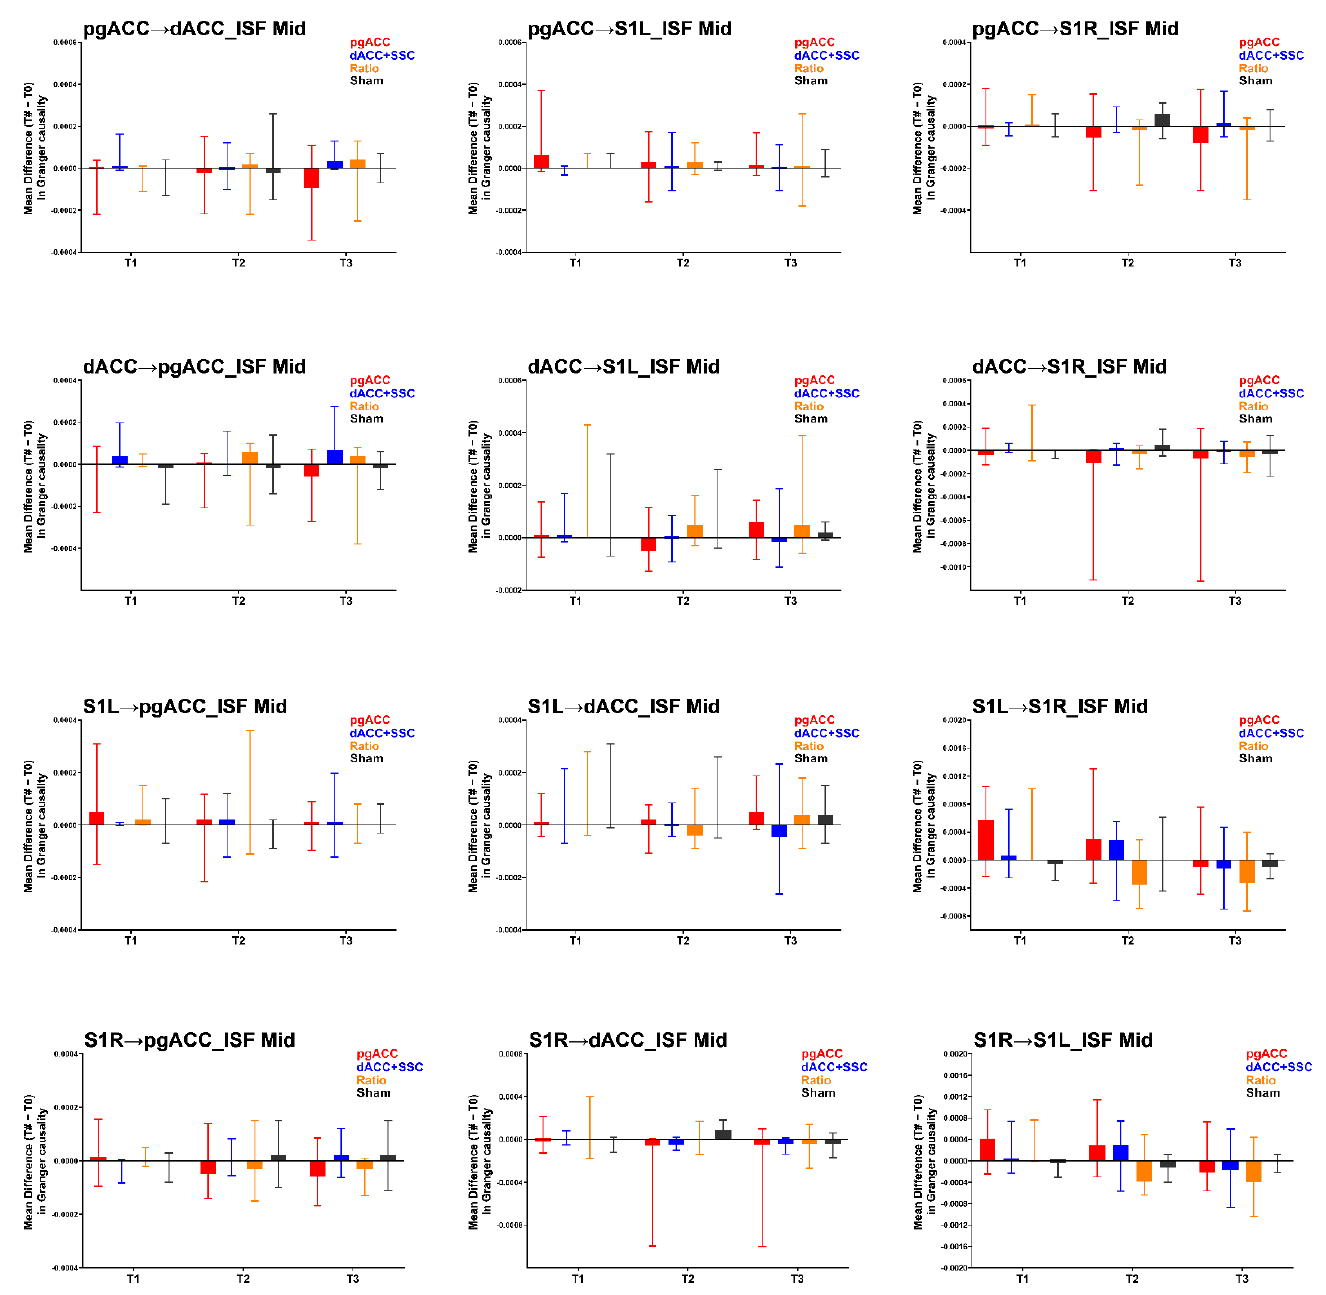
Figure 3. Results of the effective connectivity analysis for the ISF2 band (mid: 0.05–0.07 Hz). pgACC: pregenual anterior cingulate cortex; dACC: dorsal anterior cingulate cortex; S1L: primary somatosensory cortex left; S1R: primary somatosensory cortex right; ISF: infraslow frequency; T1: changes immediately post‑treatment when compared to baseline (T1–T0); T2: changes at one‑week follow up when compared to baseline (T2–T0); T3: changes at one‑month follow up when compared to baseline (T3–T0); ‑>: effective connectivity in the direction of one region to other. Higher values represent increase in the effective connectivity compared to